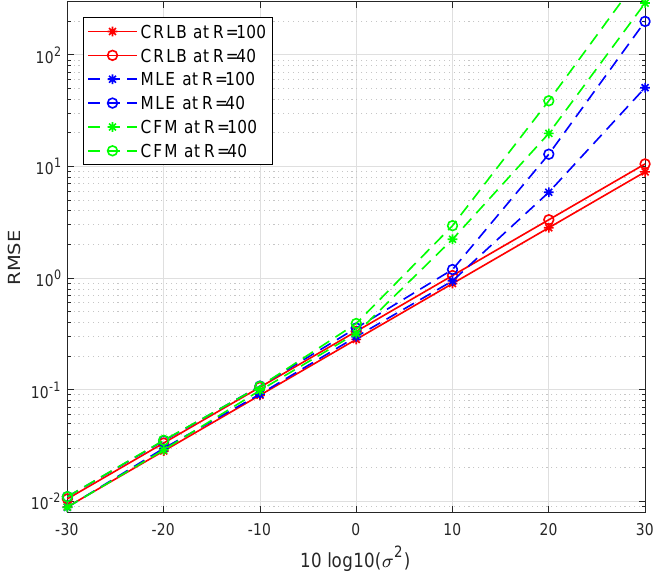
Figure 3. Comparison among CFM, MLE, and CRLB for the first